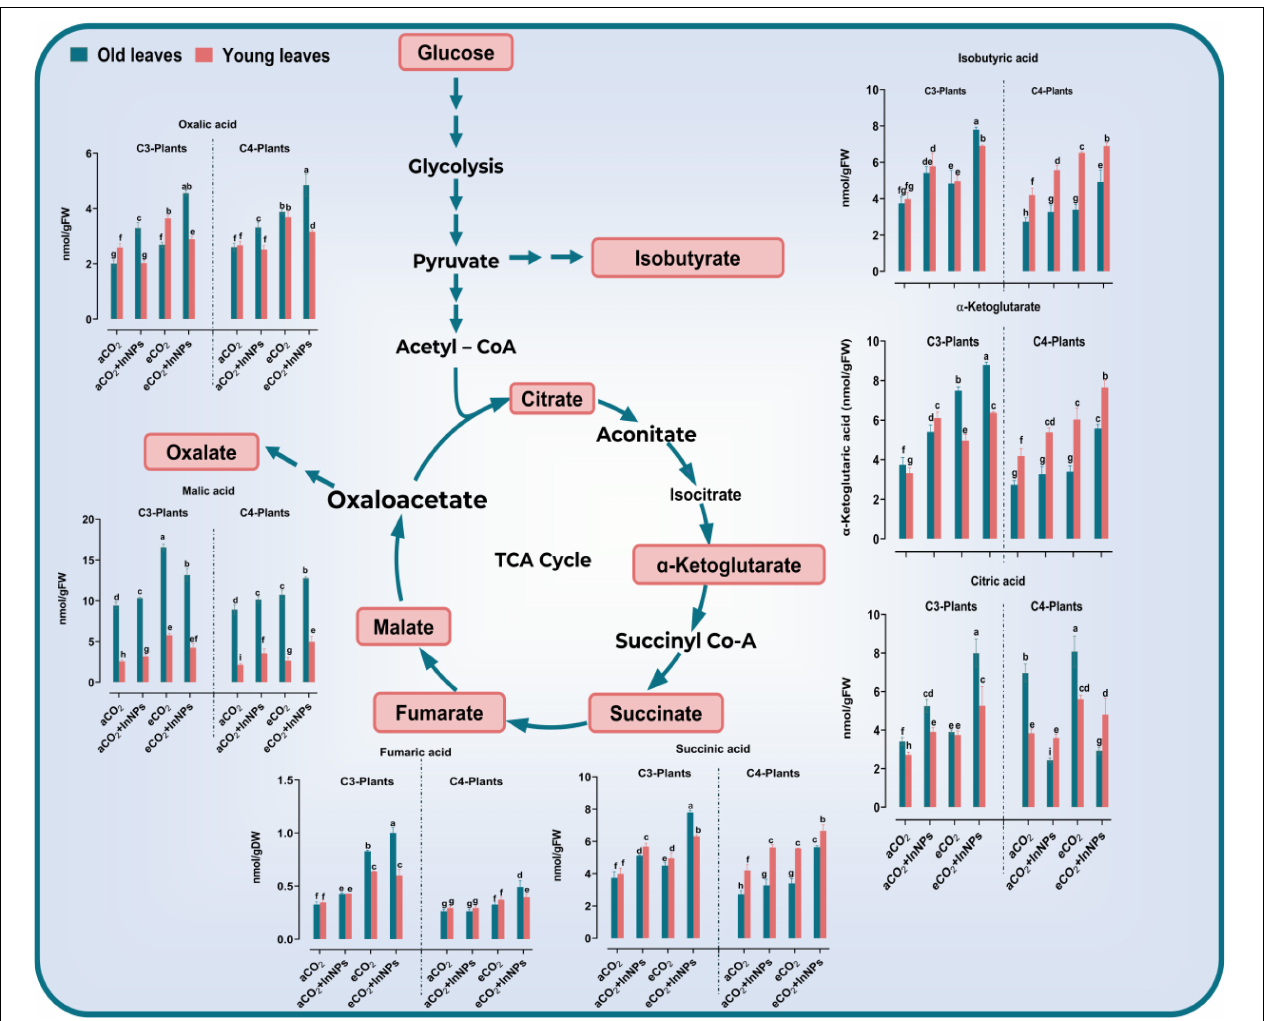
FIGURE 3 | Effect of the co-application of future climate CO 2 and In 2 O 3 -NPs upon the accumulation of organic acid in both old and young leaves of C3 and C4 plants. Four biological replicates are used to measure each value. The bars on the columns represent error bars (SE). Fisher’s LSD test ( P < 0.05; n = 4) was applied to show the significant difference between groups. Different letters showed the significant difference between